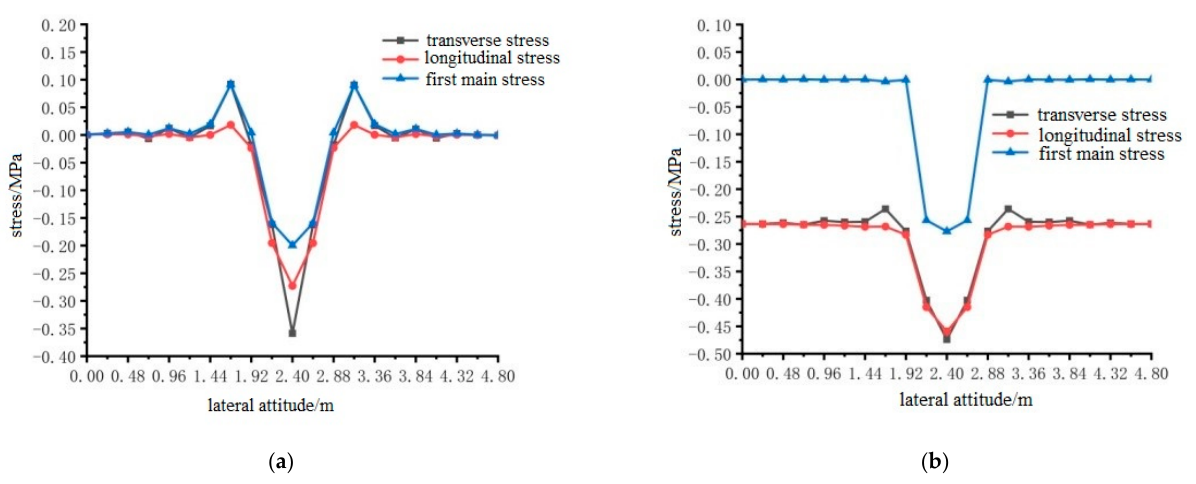
Figure 24. Horizontal distribution of longitudinal and transverse stress on the surface of the pavement with and without temperature field under the action of load level 1. ( a ) Longitudinal and transverse stress diagrams without temperature field; ( b ) Longitudinal and transverse stress diagrams with temperature field effect.